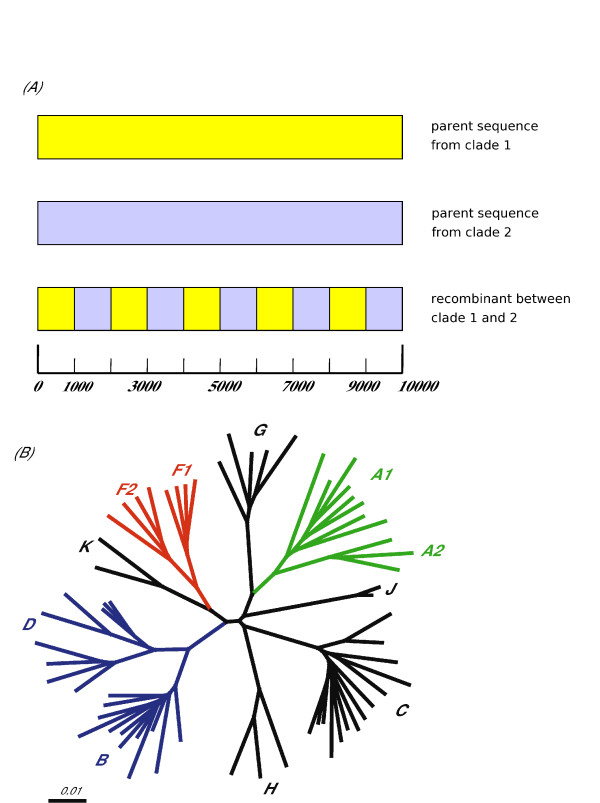
Creation of artificial recombinants with known breakpoints to test jpHMM and Simplot accuracy. (A) The artificial recombinant, constructed from two different clades, has the actual breakpoints at every X-th nucleotide for X = 500, 1000, 1500. Only the construction with X = 1000 is shown here. (B) The phylogenetic tree demonstrates the relations and relative distances between the clades used in the artificial recombinants' construction.